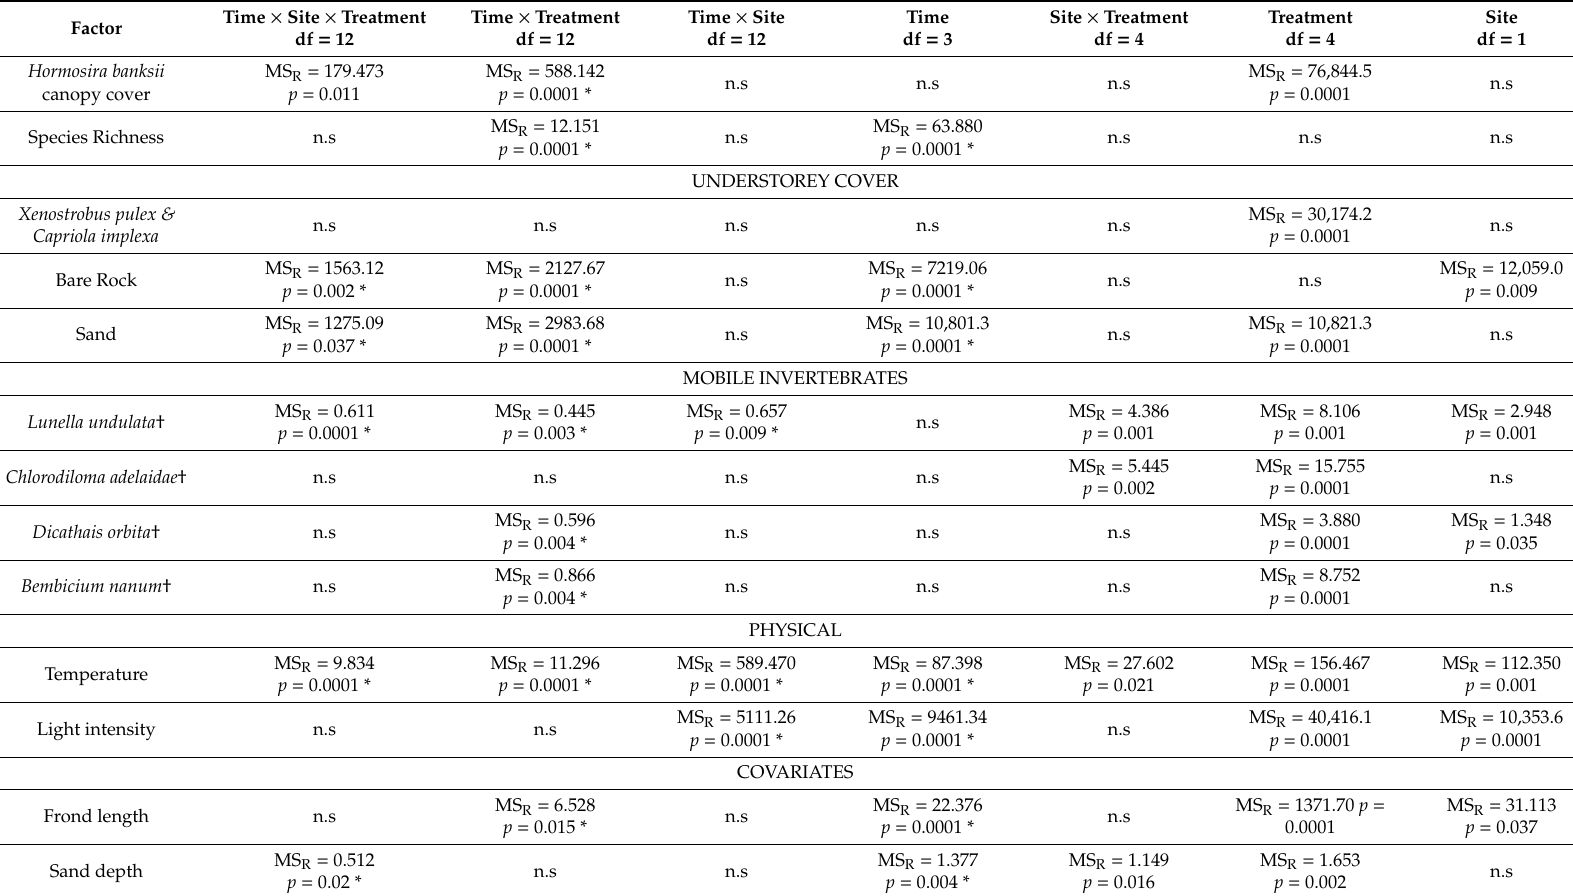
Table 1. Summary repeated measures analysis of variance (rmANOVA) results comparing factors of interest and abundances of individual taxa and understorey cover components contributing significantly (identified by Similarity Percentage (SIMPER) to di ff erences amongst Hormosira -canopy treatments, sites and time. Only times when sampling of the two sites were close to each other were included for analysis: days 1, 5, 15 / 19 and 371 / 379. MS Residual (as MS R ) and degrees of freedom (df) are provided to allow reconstruction of the full ANOVA table. * denotes P -values that were adjusted to Greenhouse-Geisser Epsilon, † denotes data Square-Root transformed to meet assumptions of normality, n.s = not significant ( p >